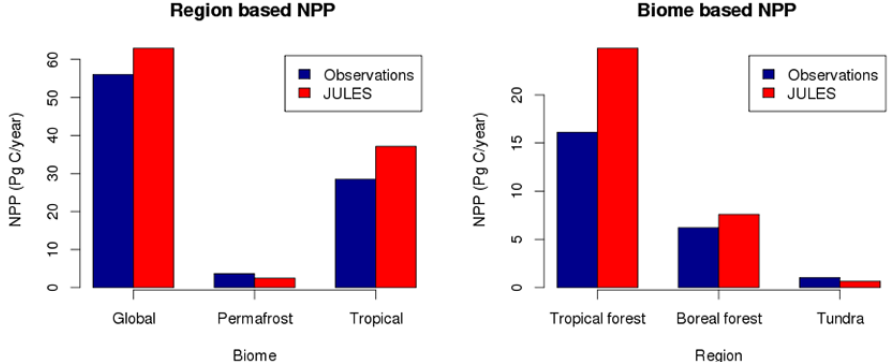
Figure 4. MODIS observed and JULES simulated annual mean NPP for the regions assessed in this paper (left-hand plot), and for the following observed biomes defined by Olson et al. (2001): tropical forest, boreal and coniferous forest, and tundra (right-hand plot). Note the different